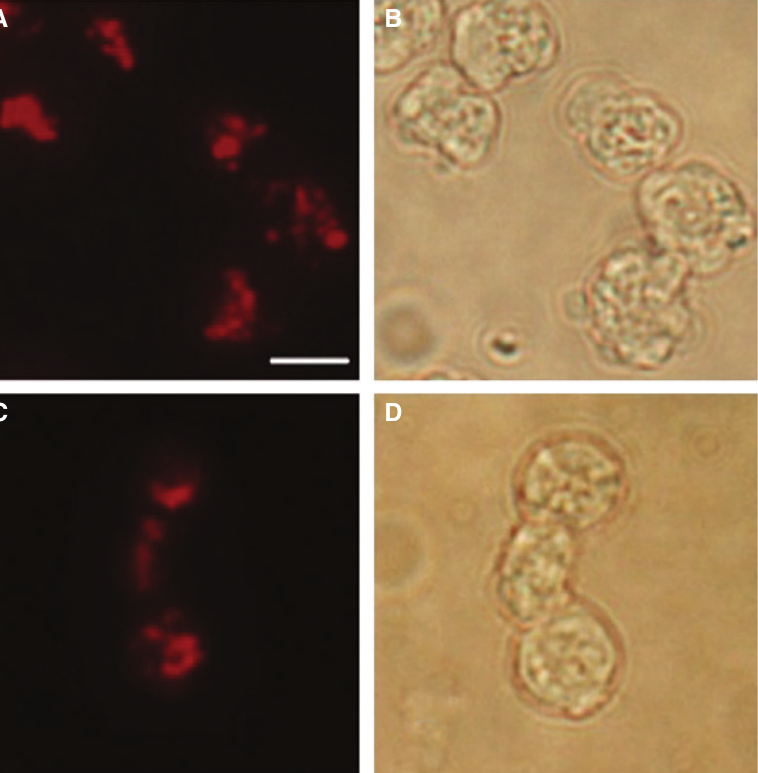
Figure 5: Mitochondria in growth phase and stationary phase cells. (A) Fluorescence microscopy images and (B) light field microscopy images of mitochondria stained with MitoTracker Orange in growth phase cells. (C) Fluorescence microscopy images and (D) light field microscopy images of mitochondria stained with MitoTracker Orange in stationary phase cells. Scale bar = 7 μ m.